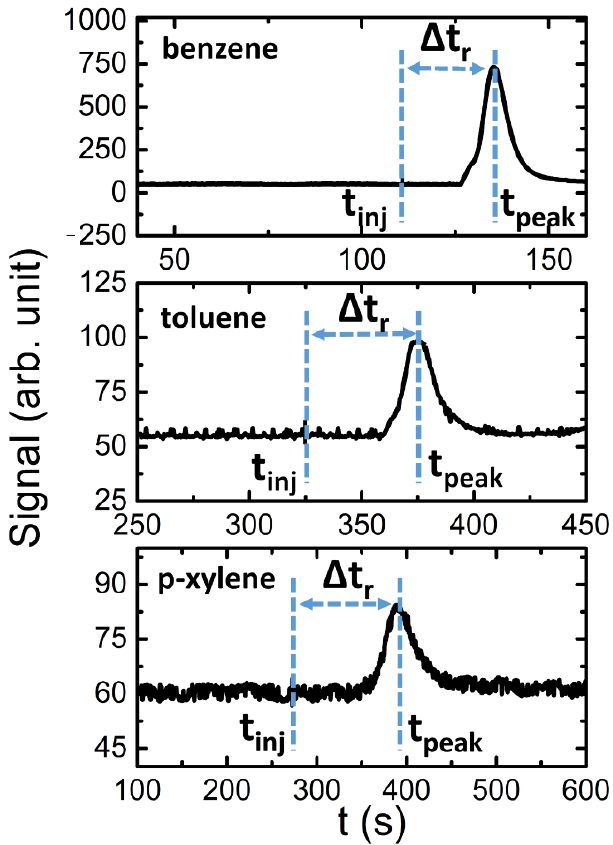
Figure 5. An example of BTX peaks, with 1.7 µg of benzene, 0.3 µg of toluene and 0.9 µg of p-xylene. In the chronograms, the instant time of injection (t inj ), the evaluated instant of signal peak (t peak ) and the relative retention time (Δtr) were drawn.